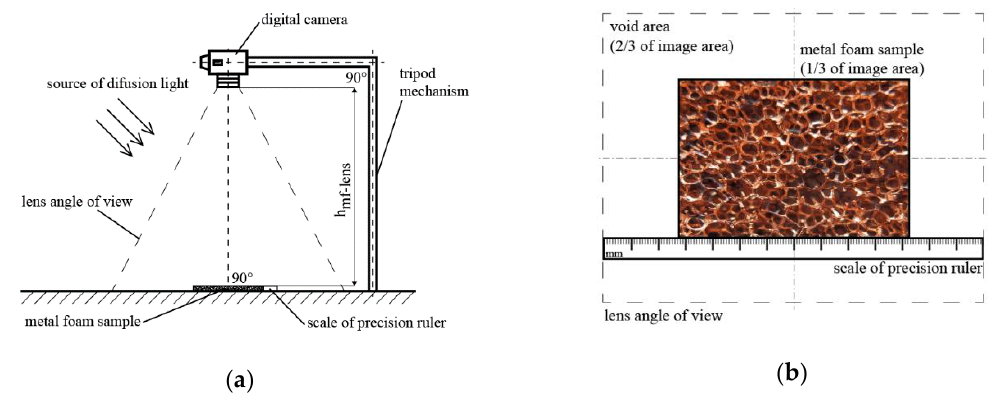
Figure 2. Schematic diagram of digital camera placement ( a ) and top view on the relation between lens angle of view and metal foam sample ( b